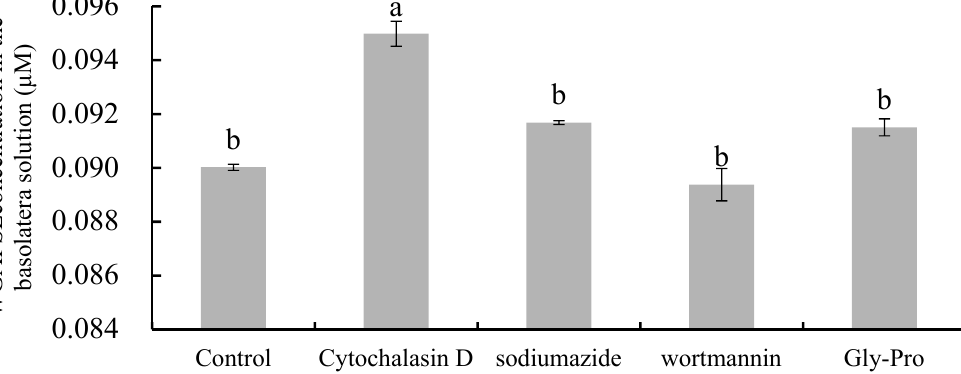
Figure 4. Effects of transport pathway inhibitors on the transport of WGAPSL in Caco-2 cell monolayers. Two mM WGAPSL (dissolved in Hanks, pH 7.4) was added to the AP side following preincubation with four transport inhibitors (cytochalasin D, sodium azide, wortmannin, and Gly-Pro) for 30 min. Different letters indicate a significant difference at p < 0.05.